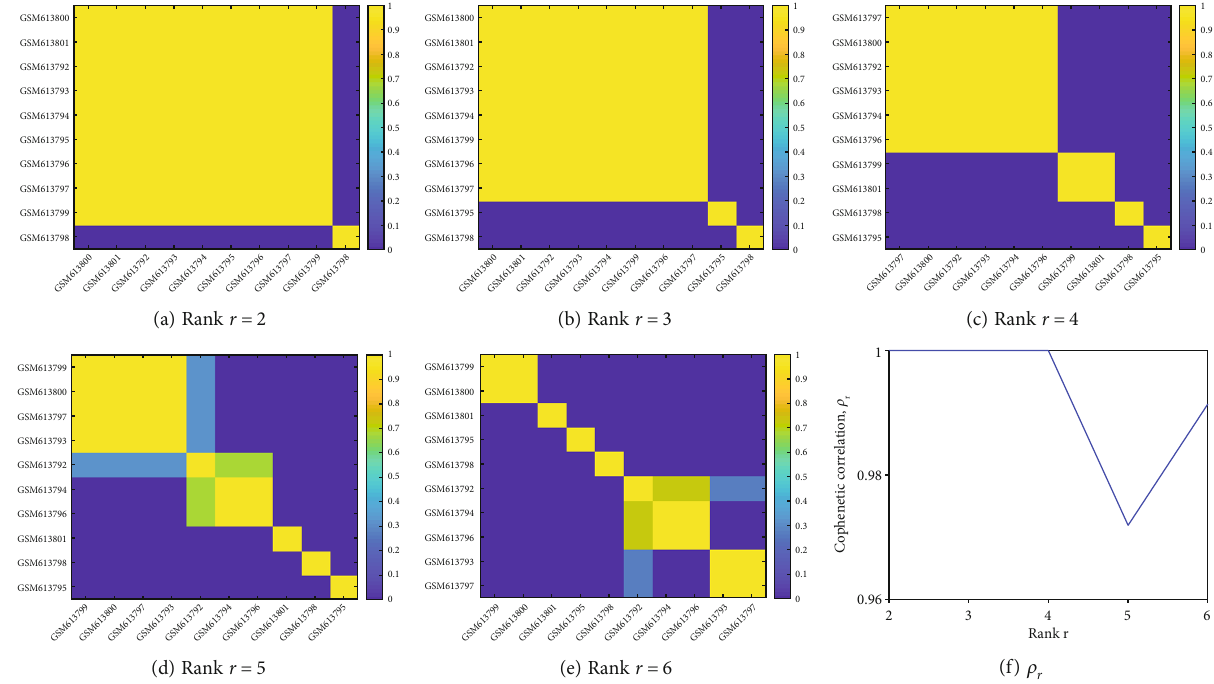
r = 2 ‐ 6 using r for